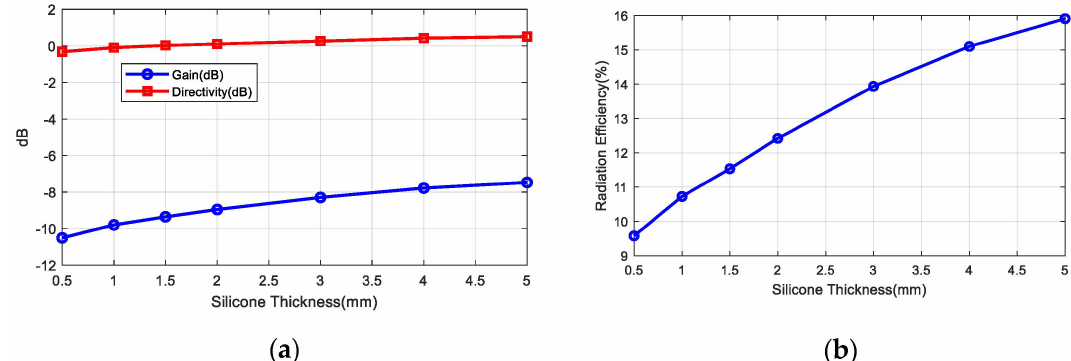
Figure 9. ( a ) Simulated gain and directivity at θ = 0 ◦ , φ = 0 ◦ , and ( b ) radiation e ffi ciency as a function of the silicone thickness at 406 MHz.